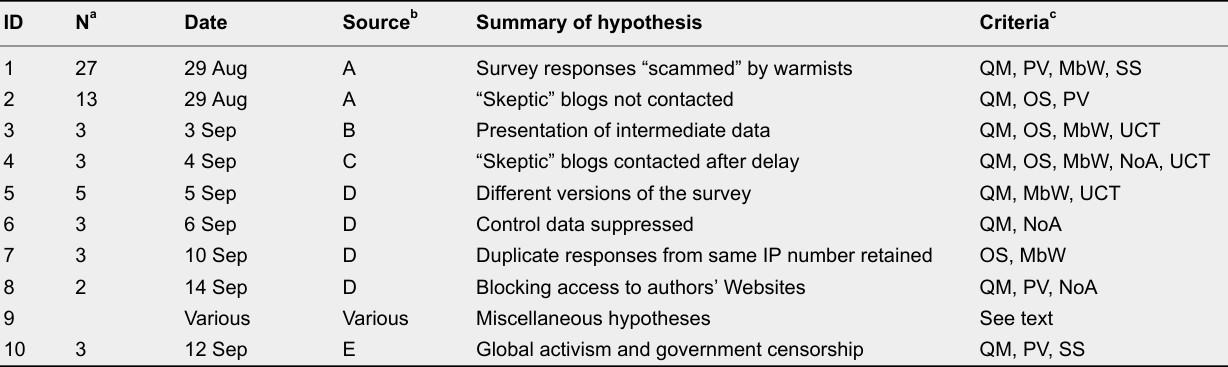
Summary of Recursive—and at Least Partially Conspiracist—Hypotheses Advanced in Response to LOG12 During August-October 2012